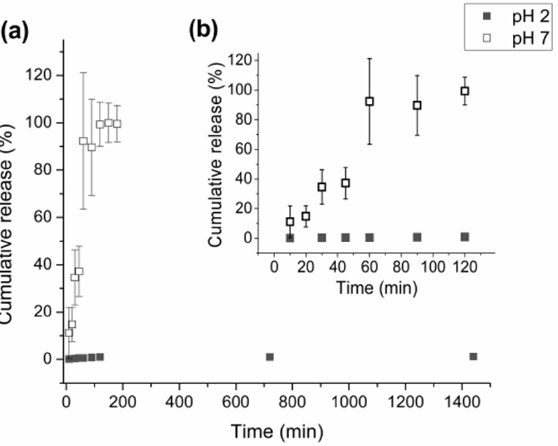
Polymers 2023 , 15 , x FOR PEER REVIEW 11 of 15